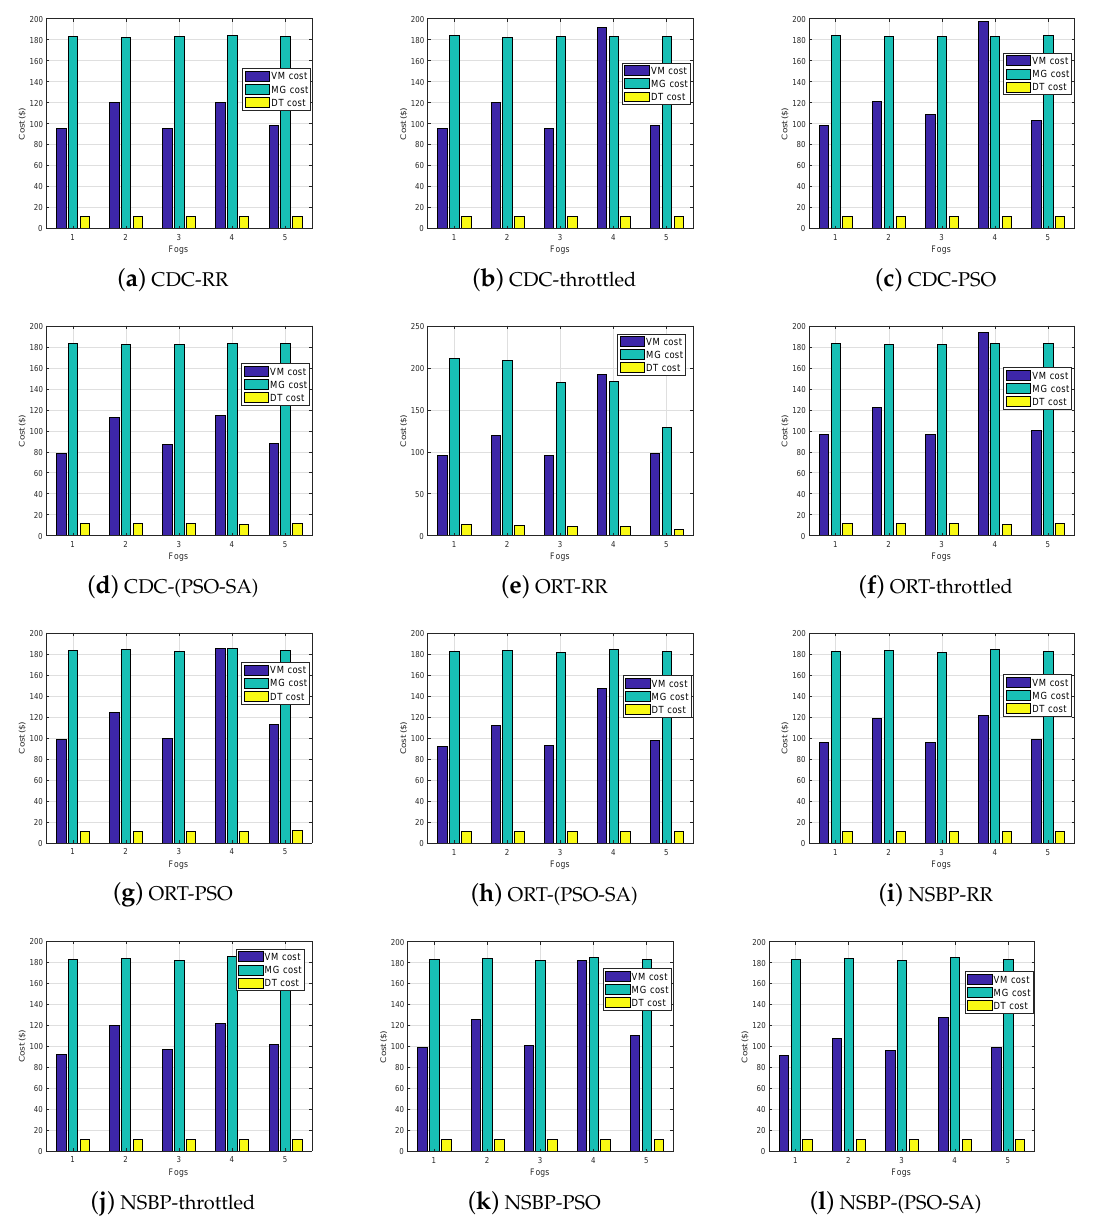
Figure 6. Cost for